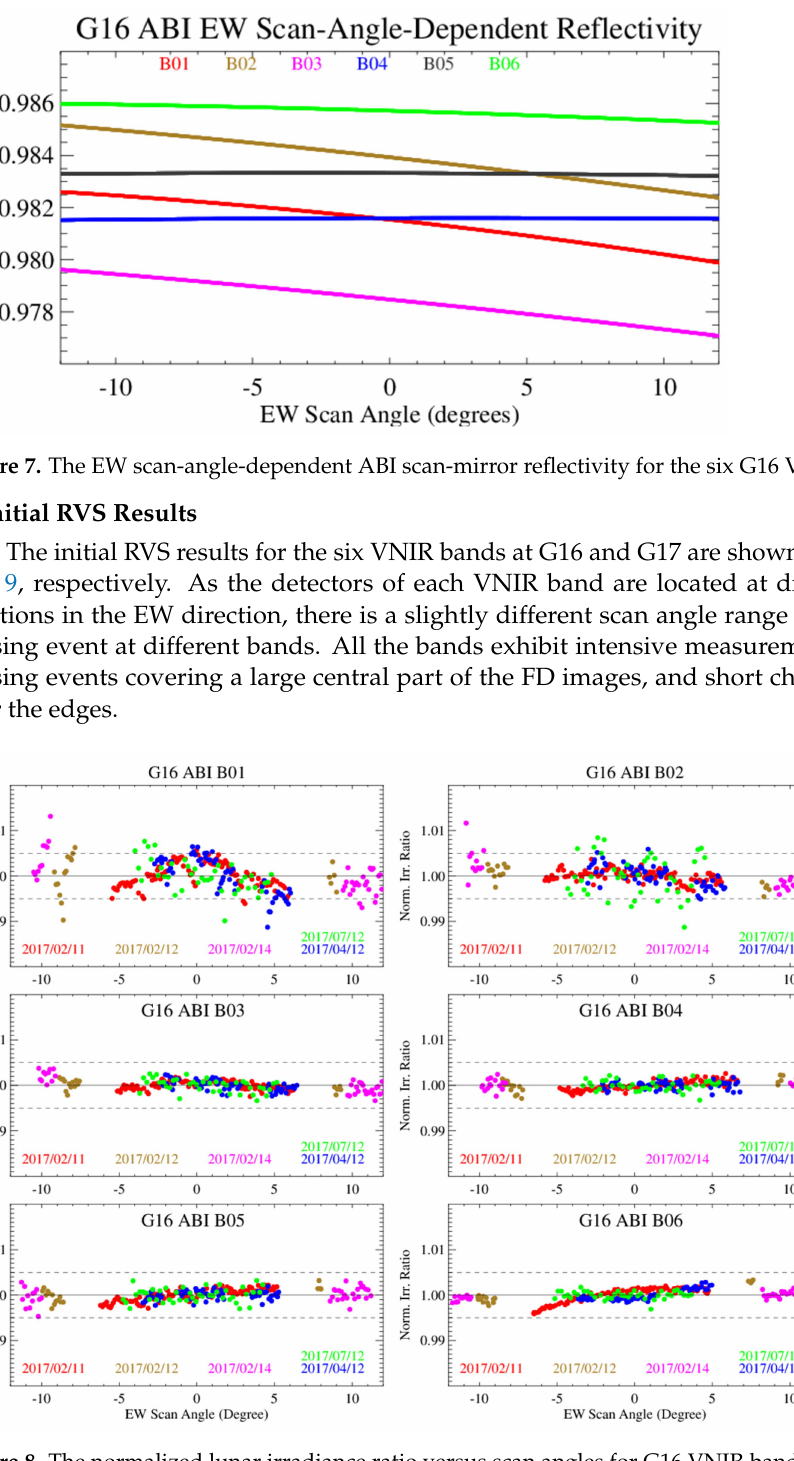
Figure 8. The normalized lunar irradiance ratio versus scan angles for G16 VNIR bands. The dashed gray lines are ± 0.5% from the mean (in solid